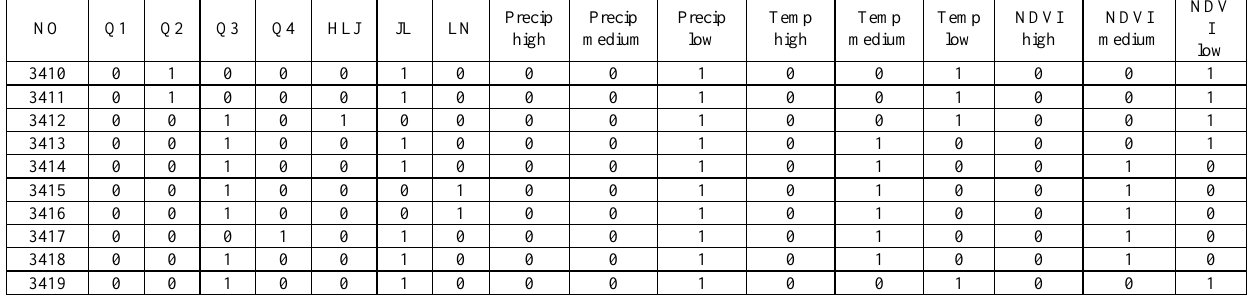
Table 3.the transactional database table ( Q means quarter, HLJ means the area of Heilongjiang